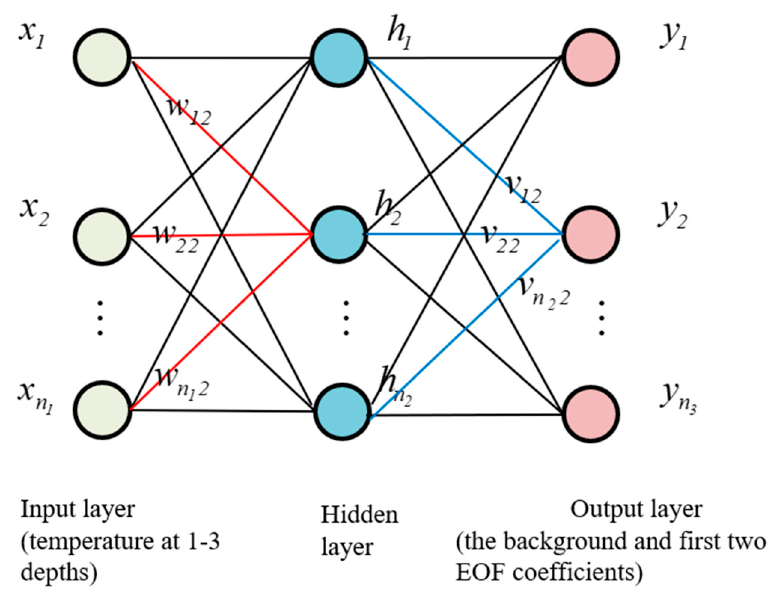
Figure 1. Topological structure of BP network.